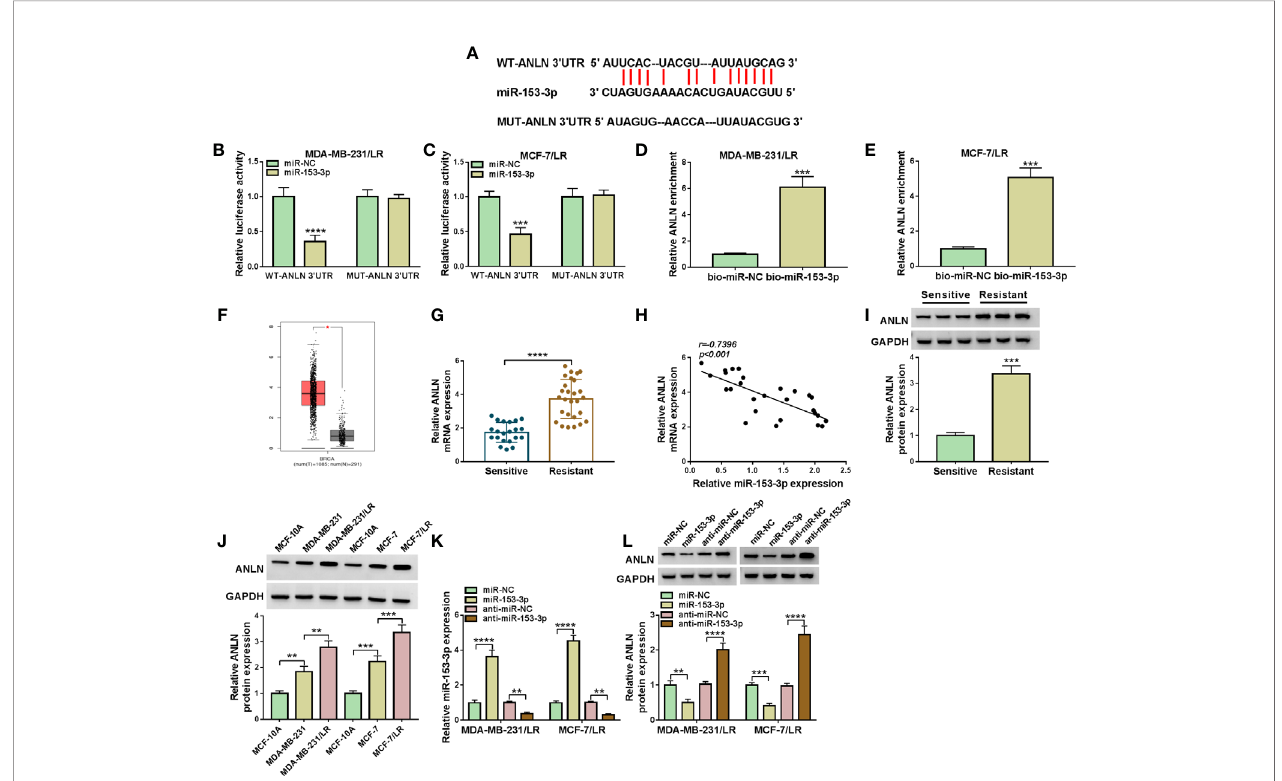
FIGURE 6 | ANLN served as the target of miR-153-3p in LR breast cancer cells. (A) Wild-type or mutant miR-153-3p-binding sites in the 3 ’ UTR sequences of ANLN were presented. (B, C) The effects of miR-153-3p upregulation on luciferase activity of WT-ANLN 3 ’ UTR and MUT-ANLN 3 ’ UTR reporters were analyzed in MDA-MB-231/LR and MCF-7/LR cells. (D, E) The interaction was con fi rmed by RNA pull-down assay. (F) GEPIA analysis showed that the expression of ANLN in BRCA tumor tissues (n = 1,085) and normal tissues (n = 291). (G) ANLN level was detected in the drug-sensitive group (n = 21) and the drug-resistant group (n = 27). (H) Pearson correlation analysis was applied to assess the expression association between miR-153-3p and ANLN in drug-resistant tissues. (I, J) ANLN protein level was tested in the drug-sensitive tissues, drug-resistant tissues, MCF-10A, MDA-MB-231, MDA-MB-231/LR, MCF-7, MCF-7/LR cells. (K, L) MiR-153-3p level and ANLN protein level were detected in MDA-MB-231/LR and MCF-7/LR cells transfected with miR-NC, miR-153-3p, anti-miR-NC, and anti-miR-153-3p, respectively. ** P < 0.01, *** P < 0.001, **** P < 0.0001 (Student ’ s t -test or ANOVA with Tukey ’ s tests), miR-153-3p relative to U6, ANLN relative to